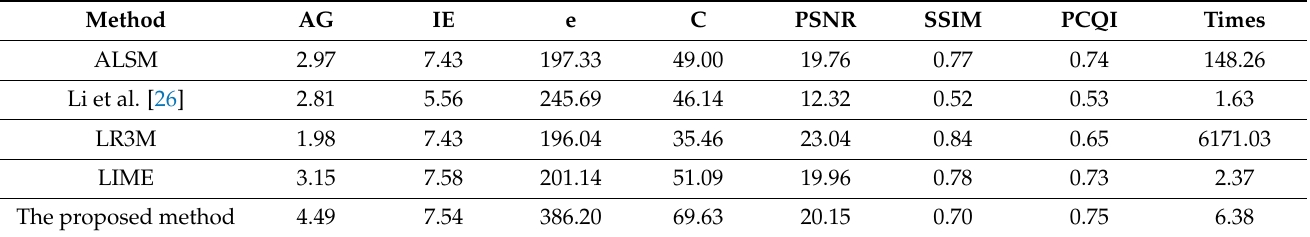
Table 1. Comparison of various indexes of multi-exposure data 1 enhanced by different methods.